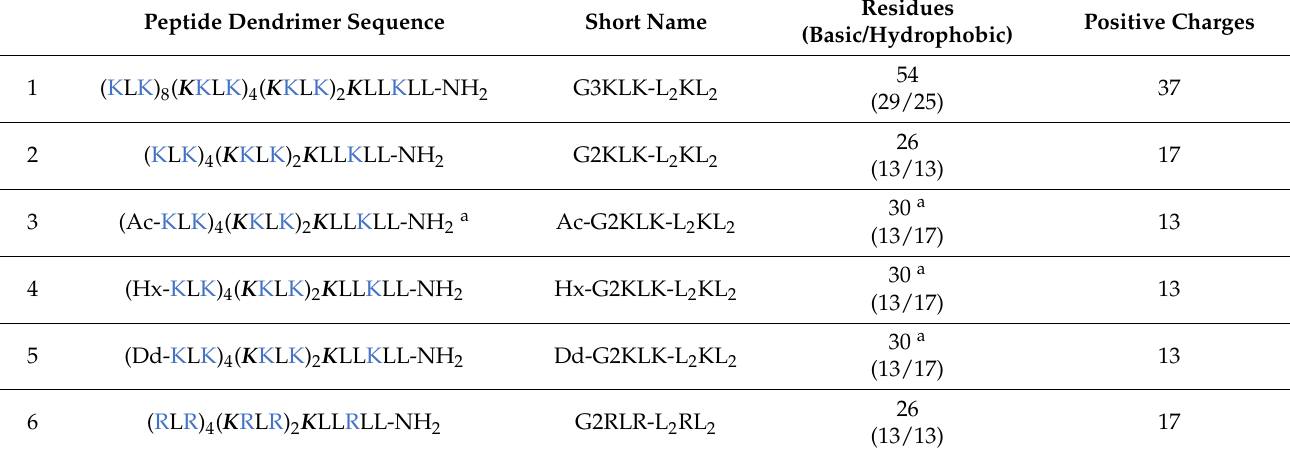
Table 1. SPCDs and their